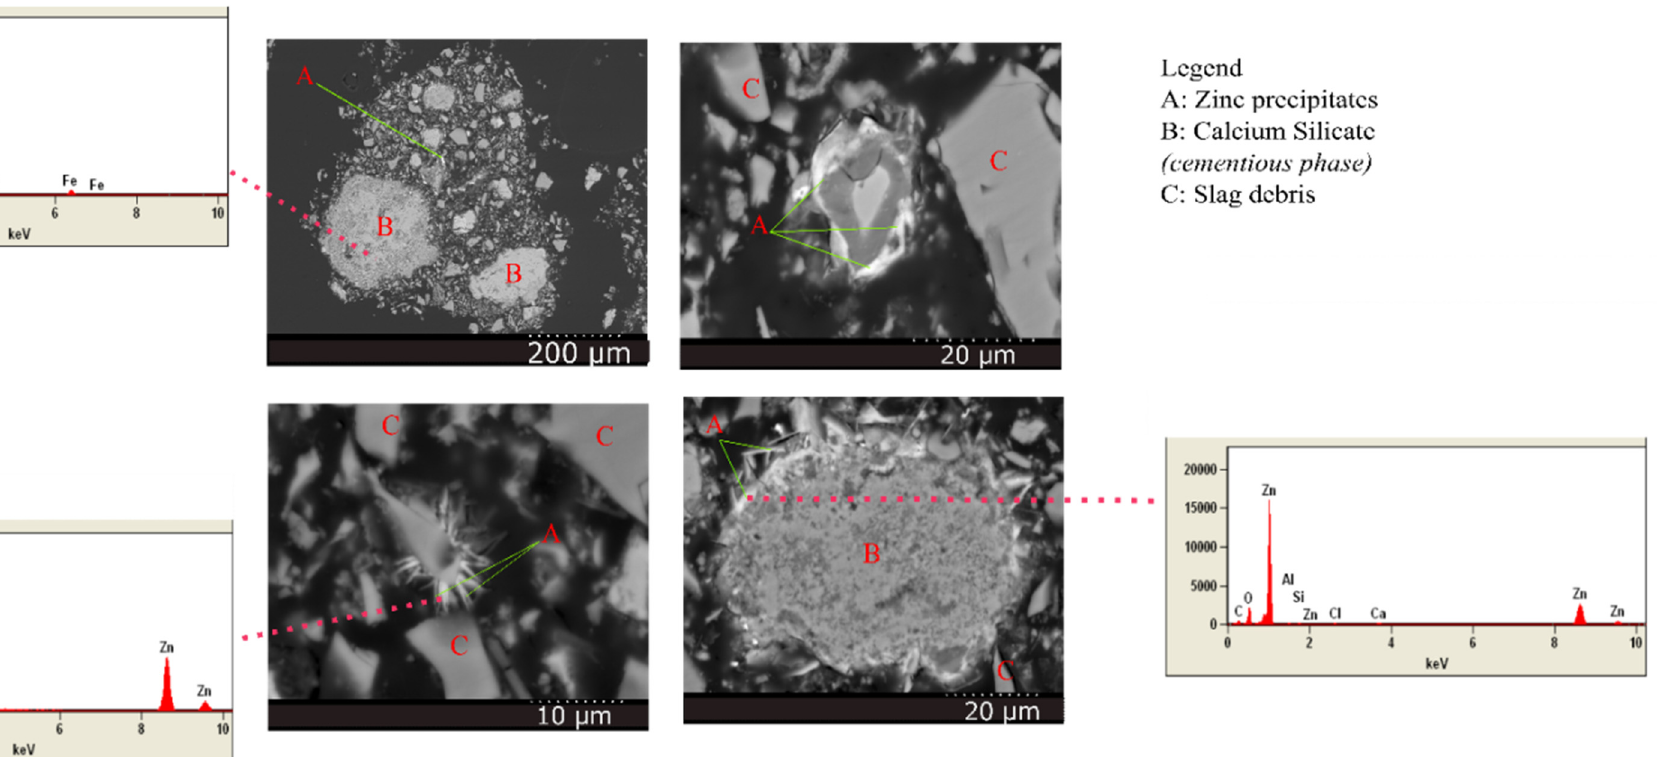
Figure 8. Microscopic characterizations (SEM/EDS) of the Slag Based Hydraulic Binder (SBHB) after interaction with zinc solution.